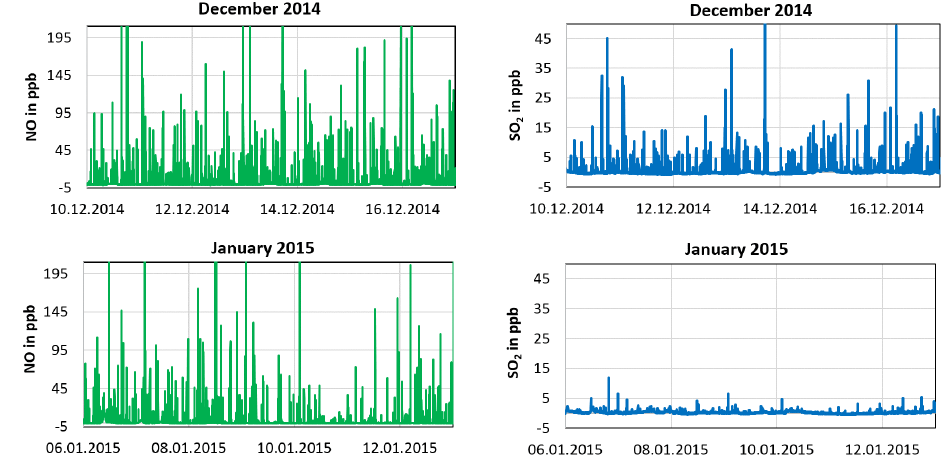
Figure 2. Comparison of absolute NO and SO 2 volume mixing ratio values measured over 2 weeks, 1 week in December 2014 and 1 week in January 2015 with comparable wind conditions. Each peak belongs to one emission plume of an individual ship. The reduction in SO 2 in 2015 is obvious, while for NO, no reduction can be observed.